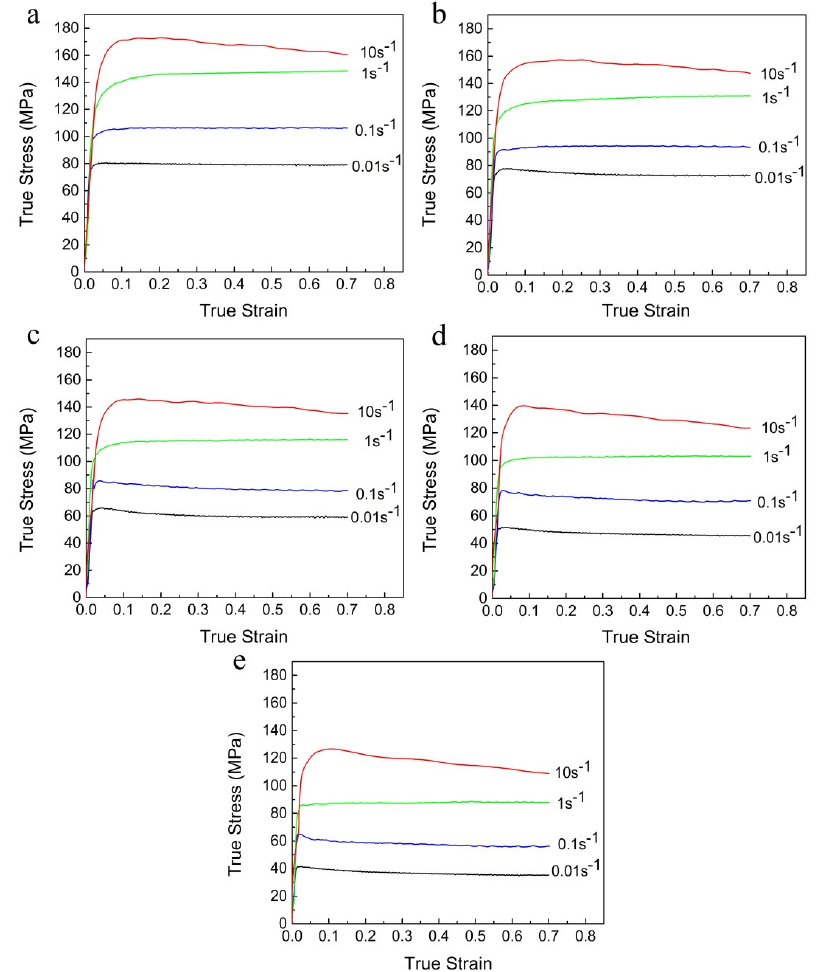
Figure 2. True stress–strain curves at deformation temperatures of ( a ) 320 ° C, ( b ) 350 ° C, ( c ) 380 ° C, ( d ) 410 ° C, and ( e ) 440 ° C.